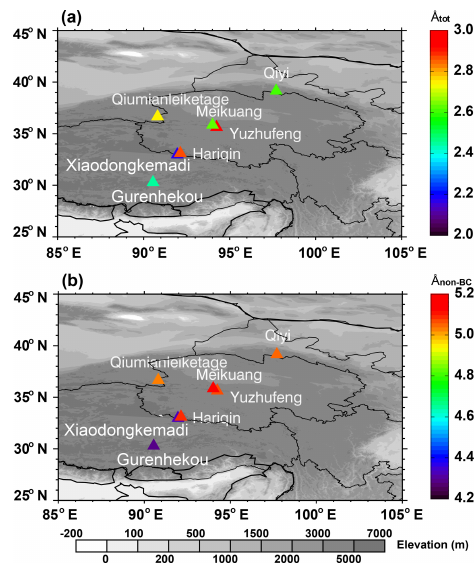
Figure 3. Spatial distribution of the averaged AOD over the TP be- tween 2013 and 2015, retrieved from Aqua MODIS at 500nm. The red stars represent sampling locations (see also Table 1).